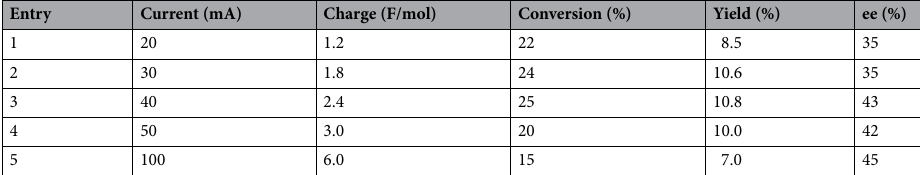
Table 2. Continuous flow elecrochemical screening of current/ charge reults with platinum as both the anode and cathode. Constant parameters: electrodes (Pt cathode/Pt anode), temperature (rt), flow rate (0.05 ml/min), concentration (0.05 M) and electrolyte (none). General procedure is followed as given above.